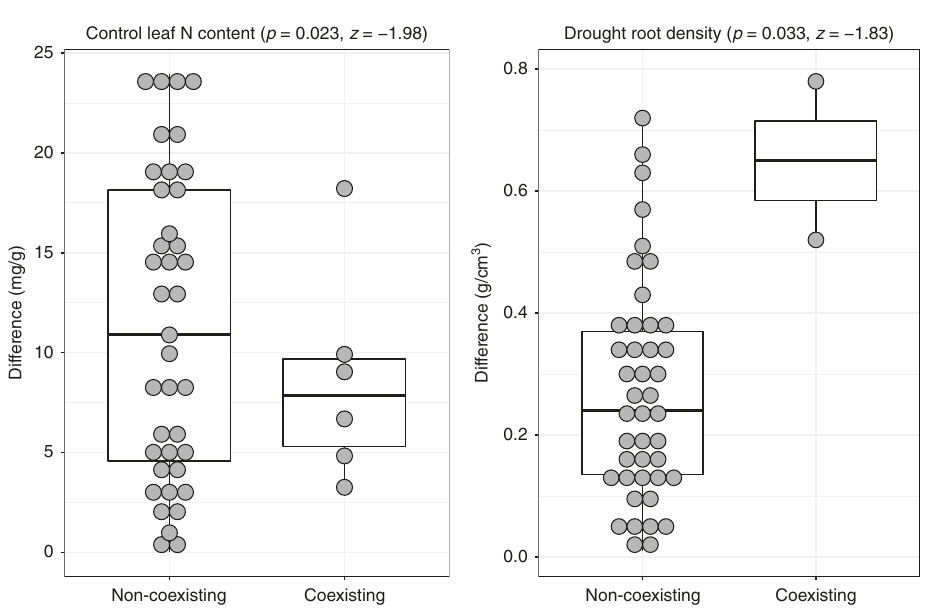
Fig. 3 Signi fi cant average trait differences between predicted coexisting and non-coexisting species pairs. Pairs predicted to coexist represented by dots are more similar in Leaf N content under climatic control conditions but more dissimilar in root density under drought (Wilcoxon signed-rank test; p < 0.05). The other trait differences were not signi fi cant. Following boxplot representation standards boxes summarize median, fi rst, and third quartile, while whiskers indicate value limits (minimum and maximum) for coexisting and non-coexisting